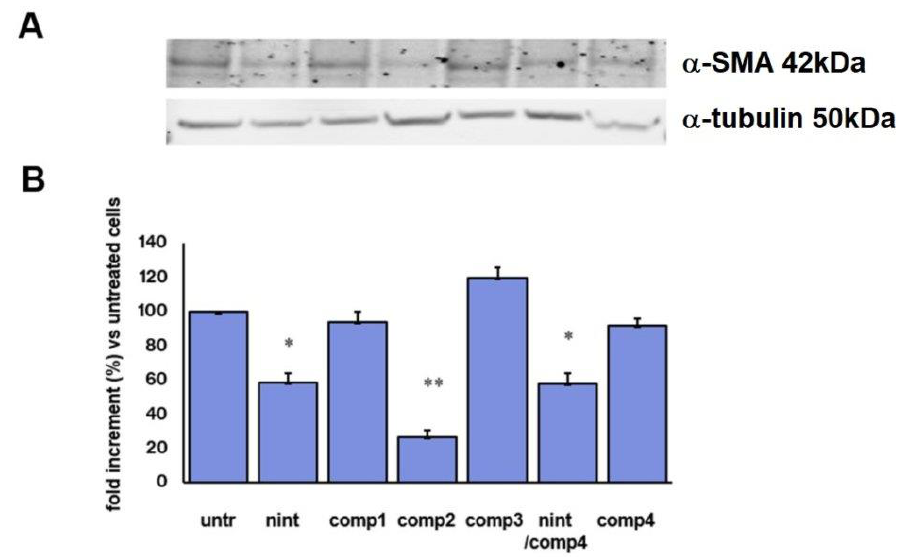
Figure 6. Expression of α -smooth muscle actin protein in TGF β -treated A549 cells grown in the presence of nintedanib (nint), compounds 1 – 3 , the combination of compound 4 with nintedanib, or compound 4 for 24 h (5 µM). ( A ) Representative Western blot analysis, ( B ) densitometric analysis of α -smooth muscle actin protein expression. Data are representative of three independent experiments ( n = 4). * p < 0.05, and ** p < 0.001 vs untreated. Data are expressed as means ± SEM of fold increment compared to untreated cells normalized to α -tubulin.